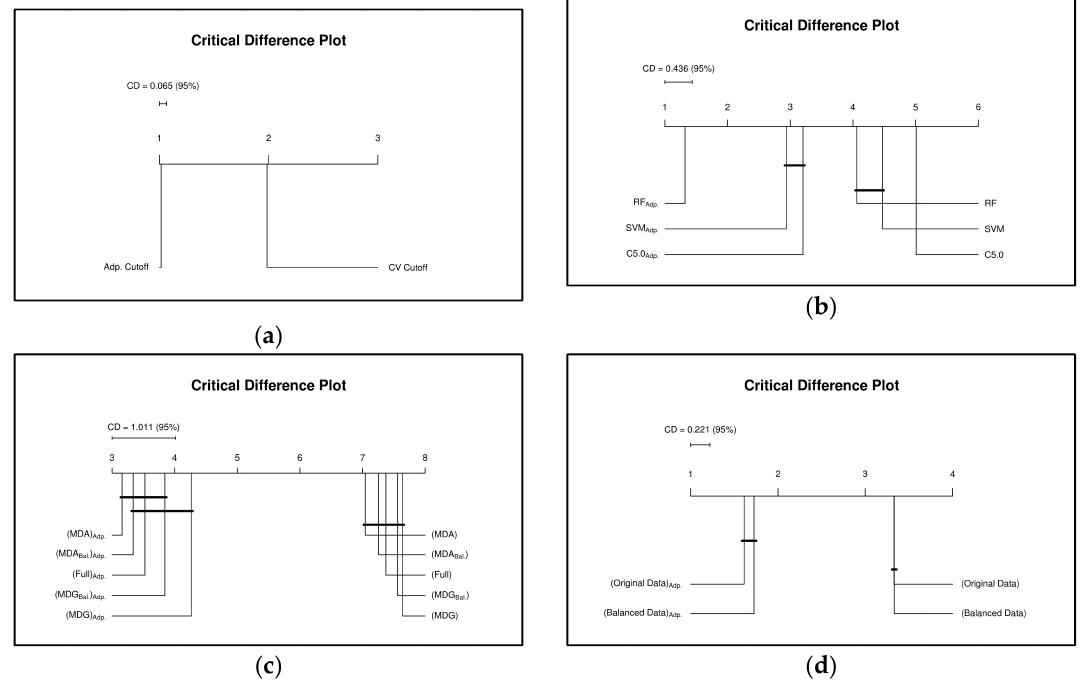
Figure 9. Graphical illustration of pairwise comparisons from the Friedman Test results for different threshold effects (optimal or adaptive cut-off) after applying the Nemenyi test (95% confidence level) (a) Fixed vs. adaptive thresholds. (b) ML algorithms under threshold adaptation effect. (c) Feature sets under threshold adaptation effect. (d) Training data balances under threshold adaptation effect.